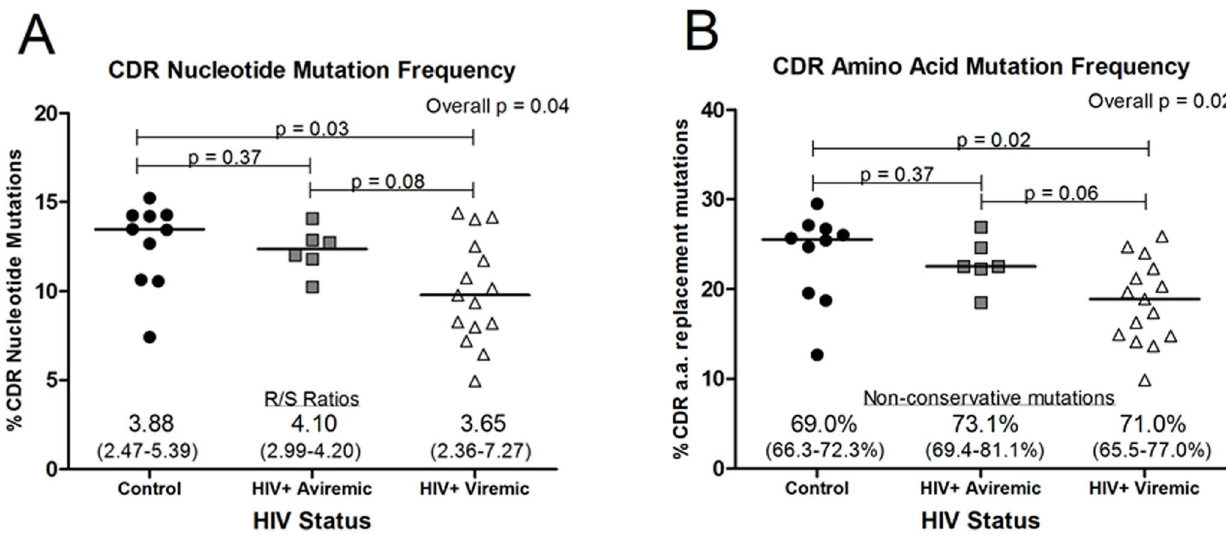
Figure 2. Mutation frequency is reduced in CDR1/2 regions of V H 3 genes from viremic HIV-1-infected patients. The mean percent of mutated nucleotides or the mean percent of replaced amino acids was calculated for each control subject (n=10; black circles), aviremic patient (n=6; gray squares), or viremic HIV-1-infected patient (n=15; white triangles) based on the alignment of the cloned sequences with V H 3 sequences from the Vbase immunoglobulin database. The solid bar indicates the group median. A) The mean percent of mutated nucleotides in the CDR1/2 regions. The median (and range) of replacement to silent (R/S) ratios indicates the number of amino acids replaced as a result of nucleotide mutations relative to unchanged (silent) amino acids (overall p=0.84). B) The mean percent of replaced amino acids in the CDR1/2 regions. The median (and range) percent non-conservative mutations was calculated relative to the total number of replaced amino acid mutations (overall p=0.02, secondary analyses: control vs. aviremic p , 0.05, all other comparisons p .